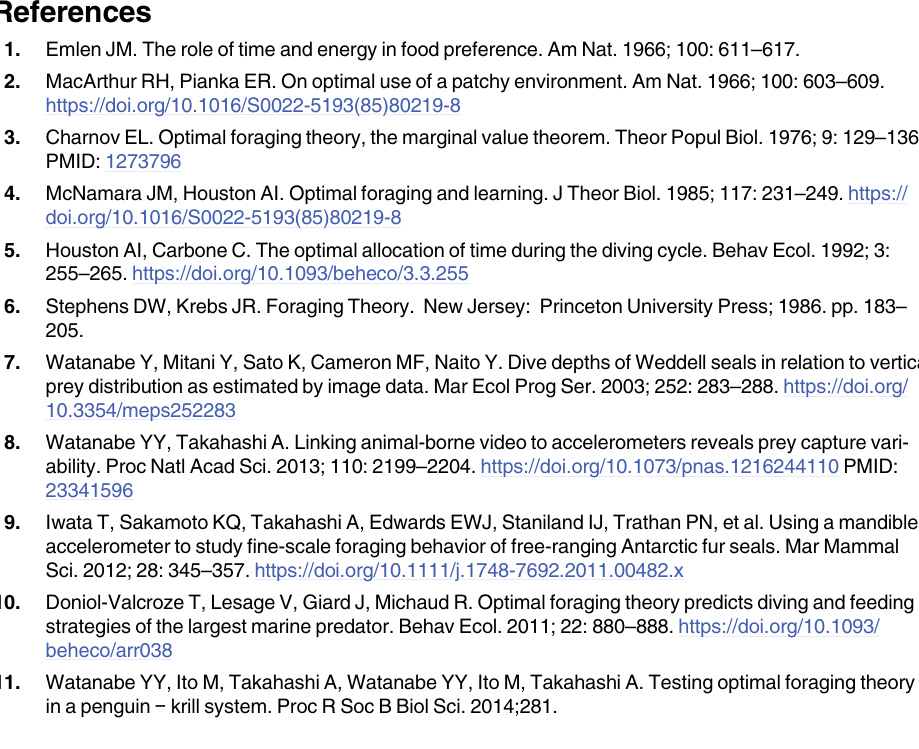
S2 File. Data used for Fig 5 and S1 Fig.